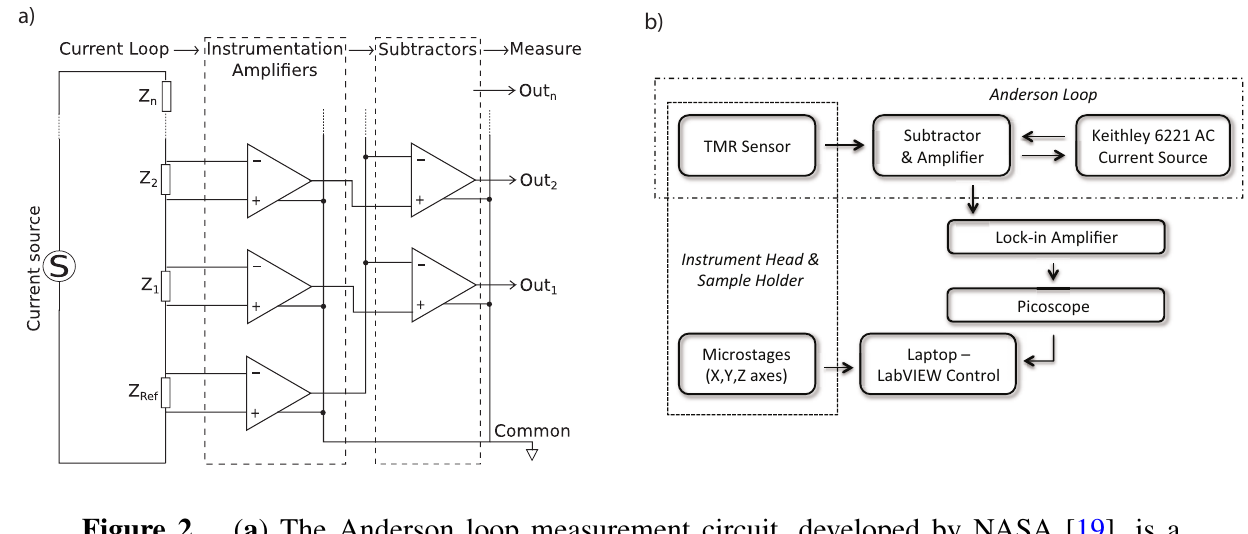
( a ) The Anderson loop measurement circuit, developed by NASA [19], is a precision current source used to supply a series of impedances, Z to Z , and a reference 1 n impedance, Z . The potential difference across each impedance is amplified by a set of ref instrumentation amplifiers. The reference signal is subtracted using a set of differencing amplifiers to give us a series of outputs, proportional to the difference between the reference impedance and each measured impedance, respectively; ( b ) Block diagram showing how all of the various pieces of equipment are connected. Note that the lock-in frequency can be defined by the Keithley power source using a trigger line or by its own internal